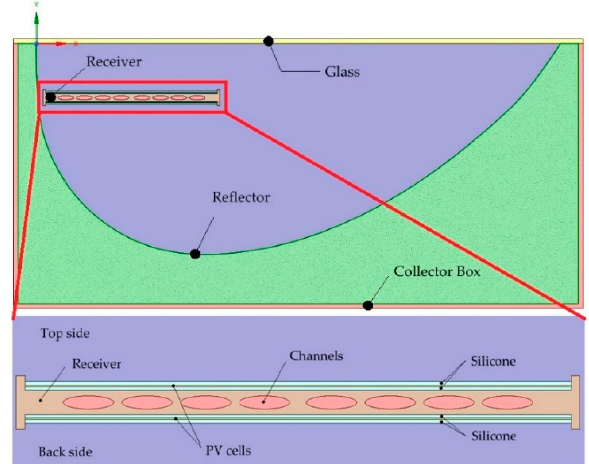
Figure 5. The geometry of the collector and details of the receiver.